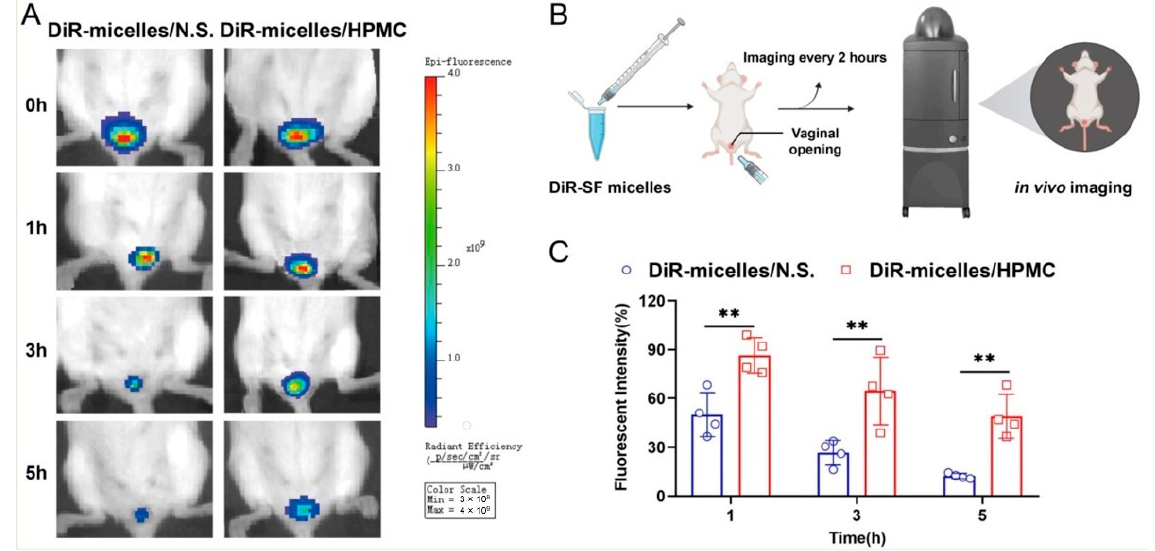
Figure 6. In vivo vaginal retention of SF micelles/N.S. or SF micelles/HPMC after vaginal administration of DiR-labelled SF micelles/N.S. (DiR-micelles/N.S.) or DiR-labelled SF micelles/HPMC (DiR-micelles/ HPMC): ( A ) Fluorescent images. ( B ) Schematic diagram of the experimental process. ( C ) Semi-quantitative fluorescent intensity (n = 4, mean ± SD). Significance criteria: ** p < 0.01.